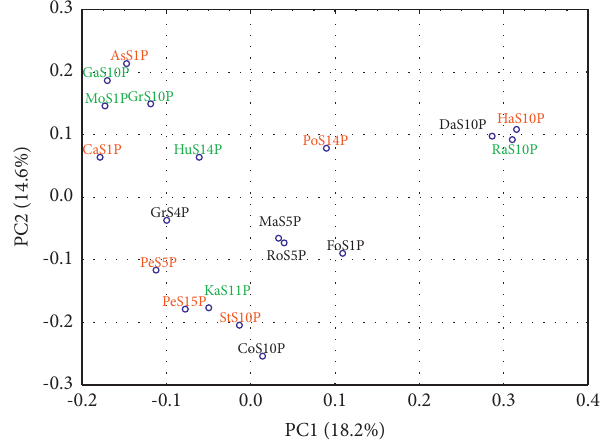
Figure 9: DISTATIS plot of the “other” group ( n � 19) derived from the sorting data. For cheese codes, the 1 st 2 letters refer to the cheese type, S1 to S15 refer to the supplier, and P (pasteurized) and R (raw) refer to the milk type. Color codes: black: 1 month; orange: 3 months; green: 6 months.